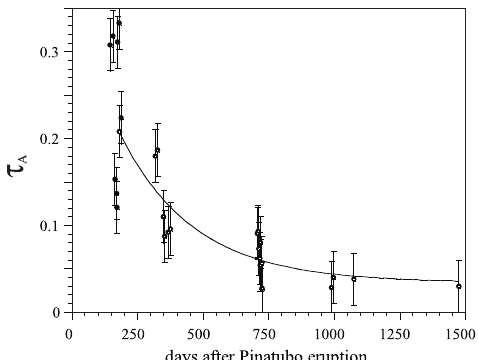
Fig. 4. Time evolution of the aerosol optical thickness t for the period 1991-1995. Also reported is the A exponentially decreasing function fi tted to the